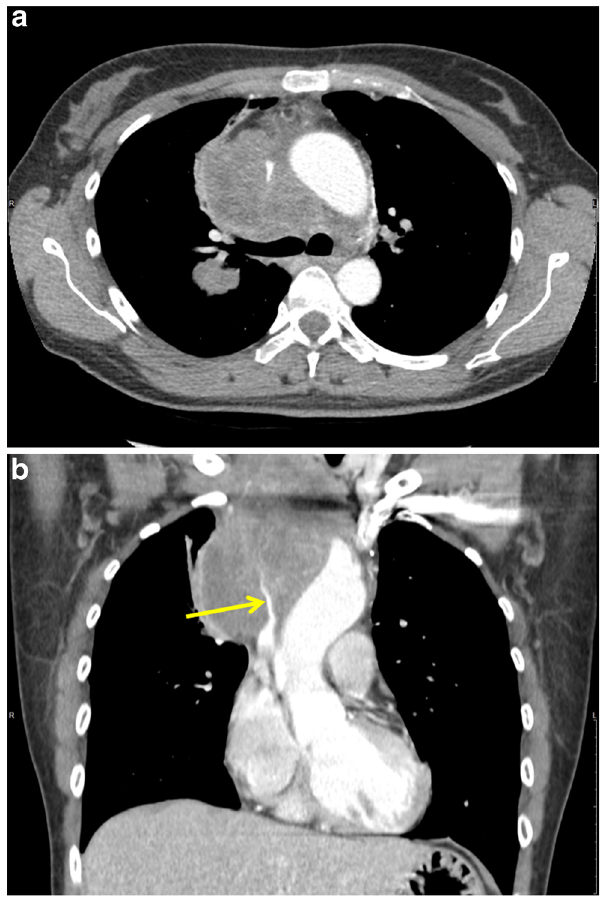
Fig. 1 Superior vena cava syndrome (SVCS) as the initial presentation of a stage IIIB small cell lung cancer in a 48-year-old woman. a Contrast- enhanced axial CT image in mediastinal window setting depicts a large mass located in the visceral mediastinal compartment with encasement of mediastinum and in particular the SVC. b CT image reconstruction in the coronal plane shows the large soft tissue mass and better depicts the prominent narrowing of the SVC ( yellow arrow )